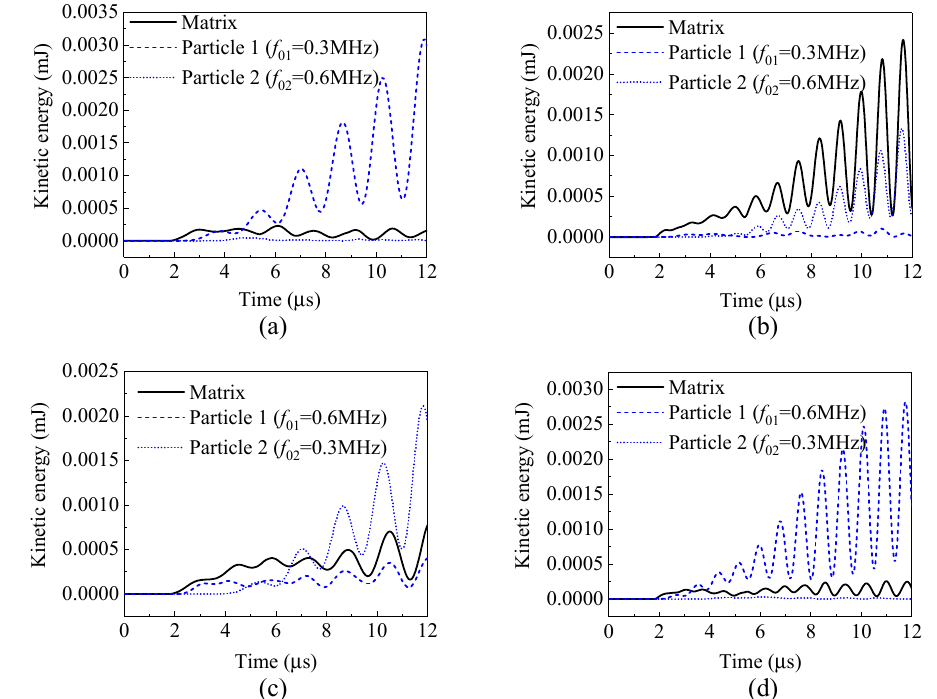
Materials 2021 , 14 , x FOR PEER REVIEW 12 of 14